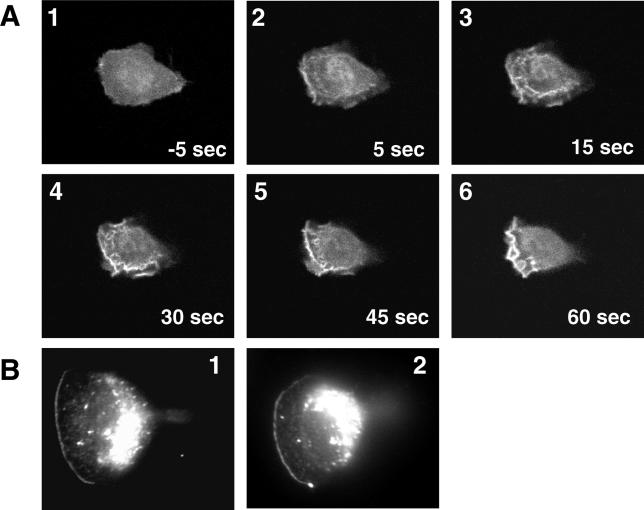
Hem-1 Strongly Polarizes following Uniform Stimulation of HL-60 cells(A) Differentiated HL-60 cells expressing GFP-tagged Hem-1 were exposed to uniform 20 nM fMLP (at t = 0 s) and imaged with a spinning disk confocal microscope at 5-s intervals at 37 °C. See Video S1.(B) Human neutrophils obtained from finger pinprick [80] were exposed to uniform 20 nM fMLP for 3 min, fixed, and immunostained for endogenous Hem-1. Hem-1 immunostaining is observed at the leading edge of polarized cells (and also bright staining in the cytosol).